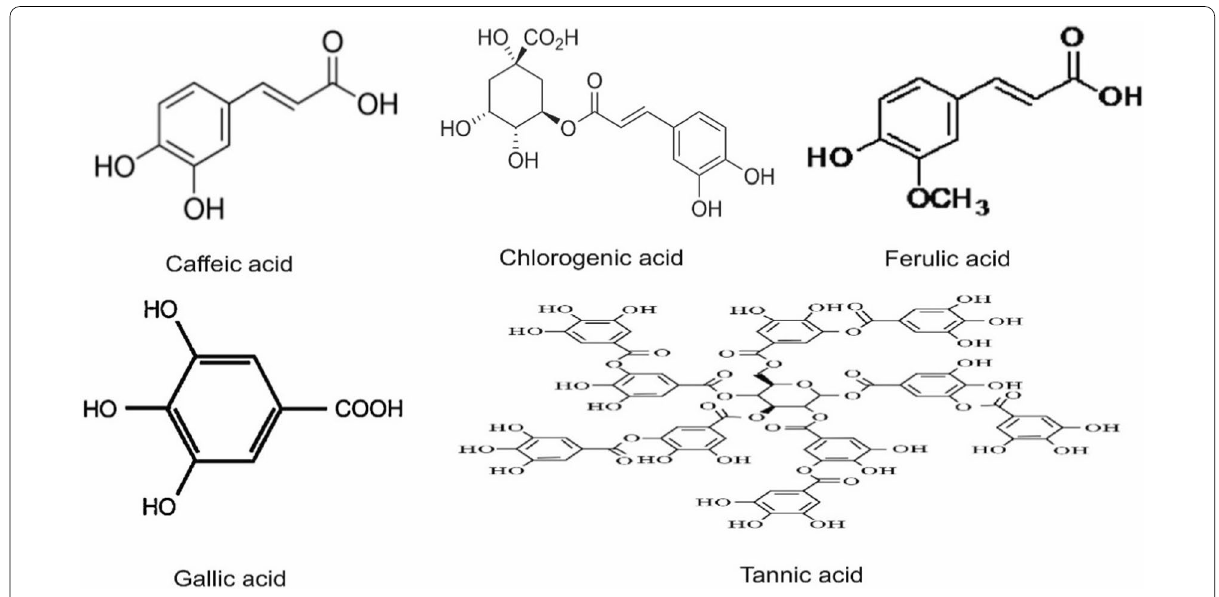
Fig. 5 Chemical structure of selected phenolic